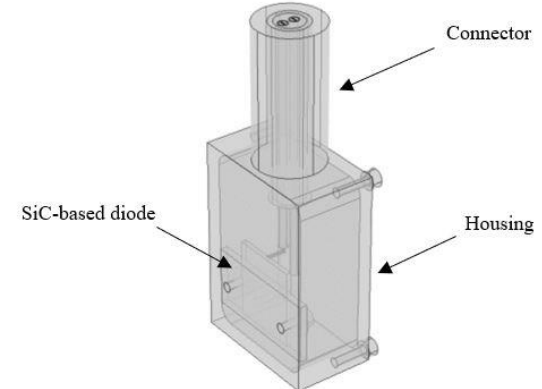
Fig. 1. 3-D schematic of the studied SiC-based detector and its three main parts. The main dimensions are presented bellow in Table